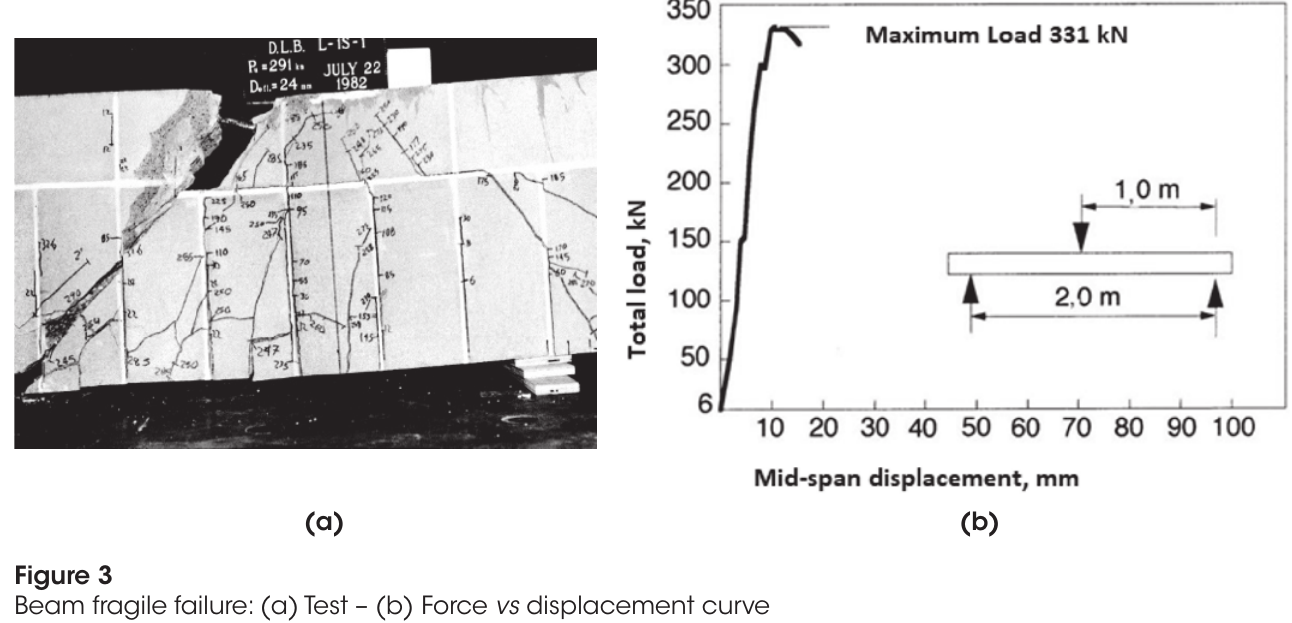
Beam fragile failure: (a) Test – (b) Force vs displacement